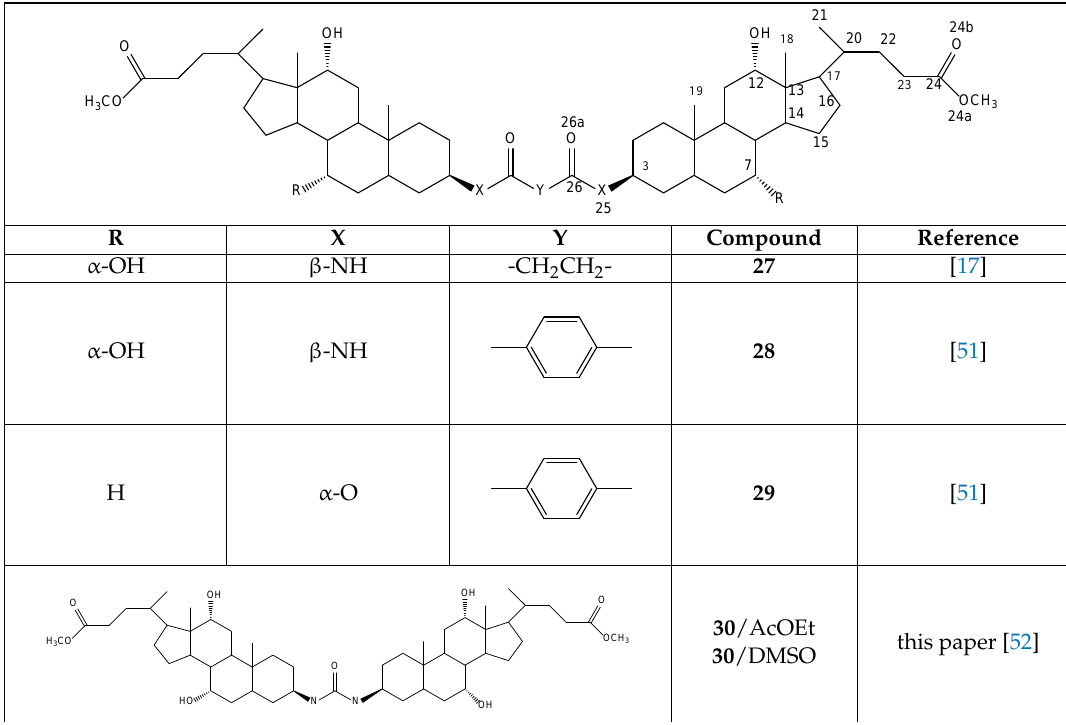
Table 2. Chemical structure and partial numbering of the dimers analyzed in this paper ( 30 /AcOEt and Crystals 2018 , 8 , x FOR PEER 30 /DMSO make reference to the recrystallization solvent included as a guest in the crystal structure).